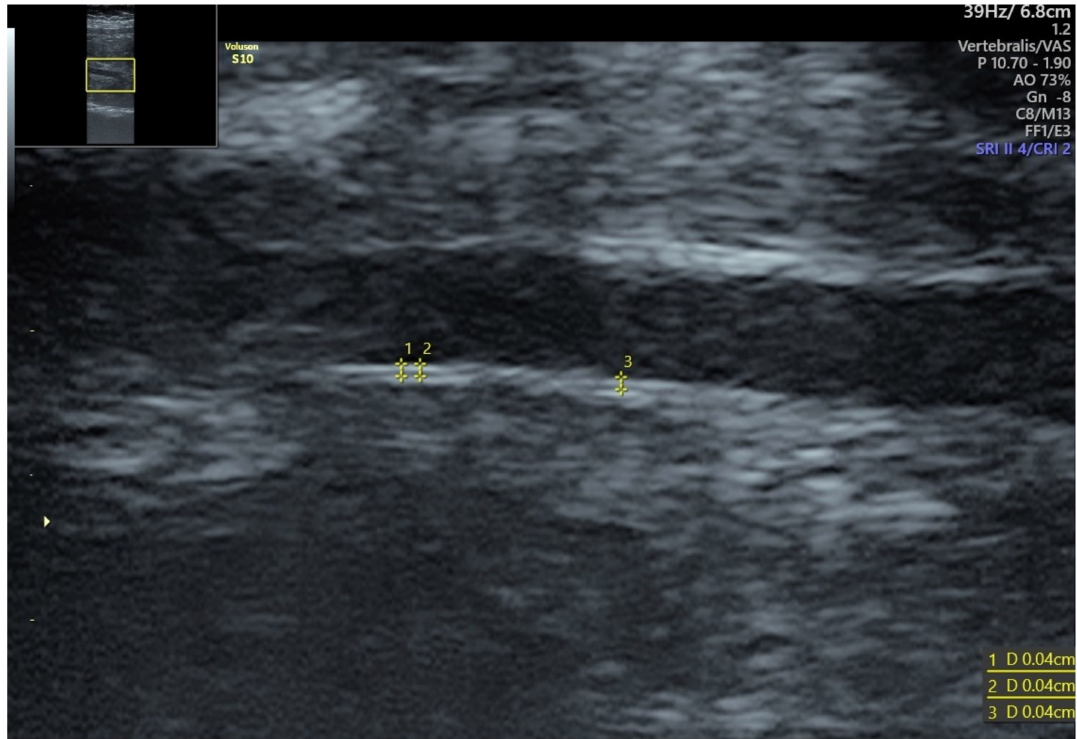
Figure 1. Intima-media thickness of fetal abdominal aorta in the 29th week of